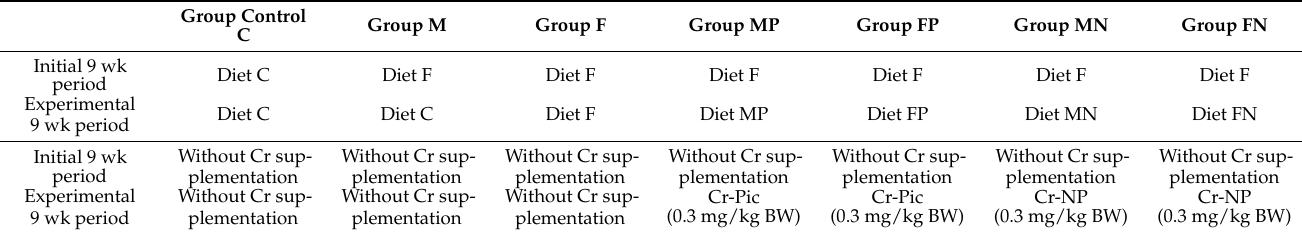
Table 6. Schema of the experimental groups * ( n =